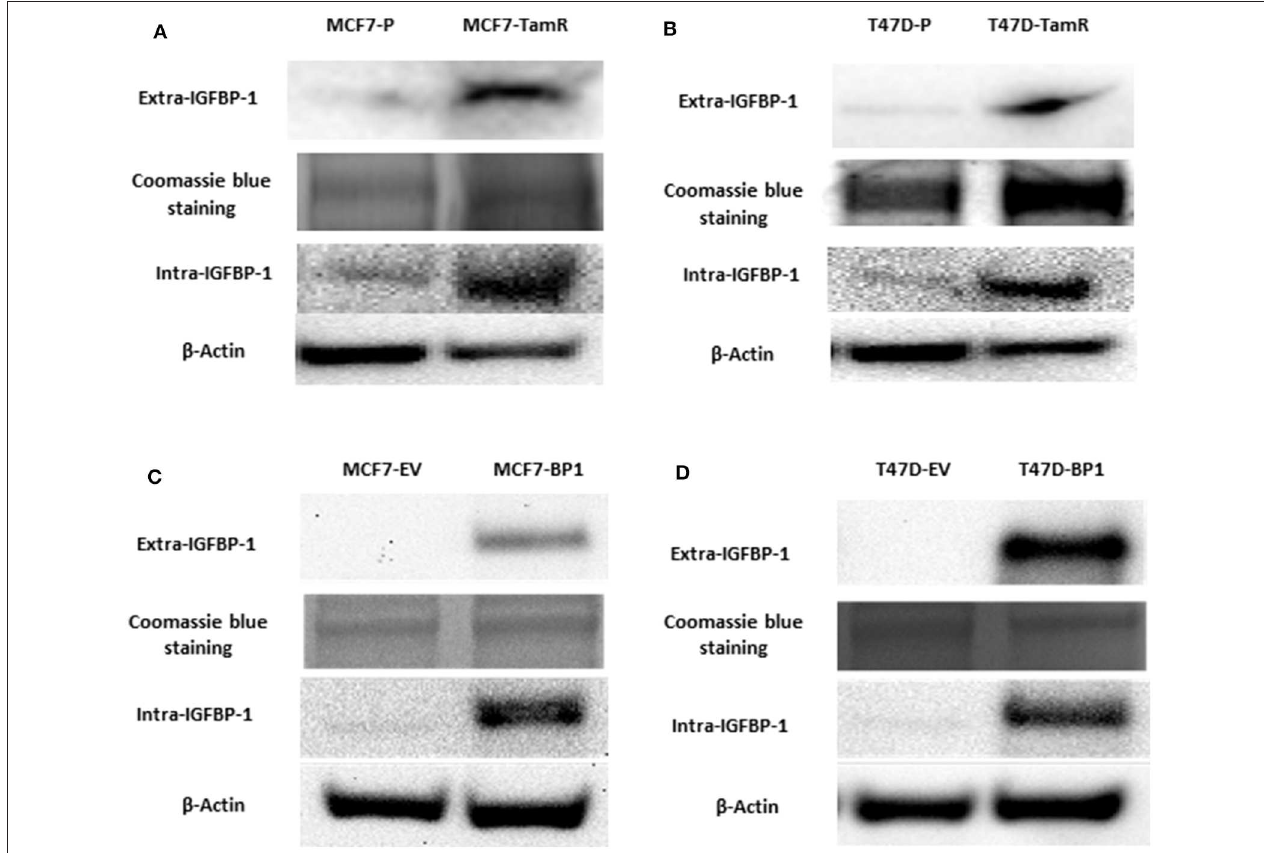
FIGURE 1 | MCF7-TamR and T47D-TamR expressed more IGFBP-1 and the establishment of MCF7-BP1 and T47D-BP1 stable cell lines. Immunoblot analysis of IGFBP-1 expression in MCF-7 and T-47D stable cells. (A) Measurement of IGFBP-1 expression in MCF7-P and MCF7-TamR (left), and in T47D-P and T47D-TamR (right); (B) measurement of IGFBP-1 expression in MCF7-EV and MCF7-BP1 (left), and in T47D-EV and T47D-BP1 (right). The Coomassie blue staining indicated the even loading of the proteins from the concentrated media. Results are the representatives of 3 independent experiments. Extra-IGFBP-1: extracellular IGFBP-1; intra-IGFBP-1: intracellular IGFBP-1.